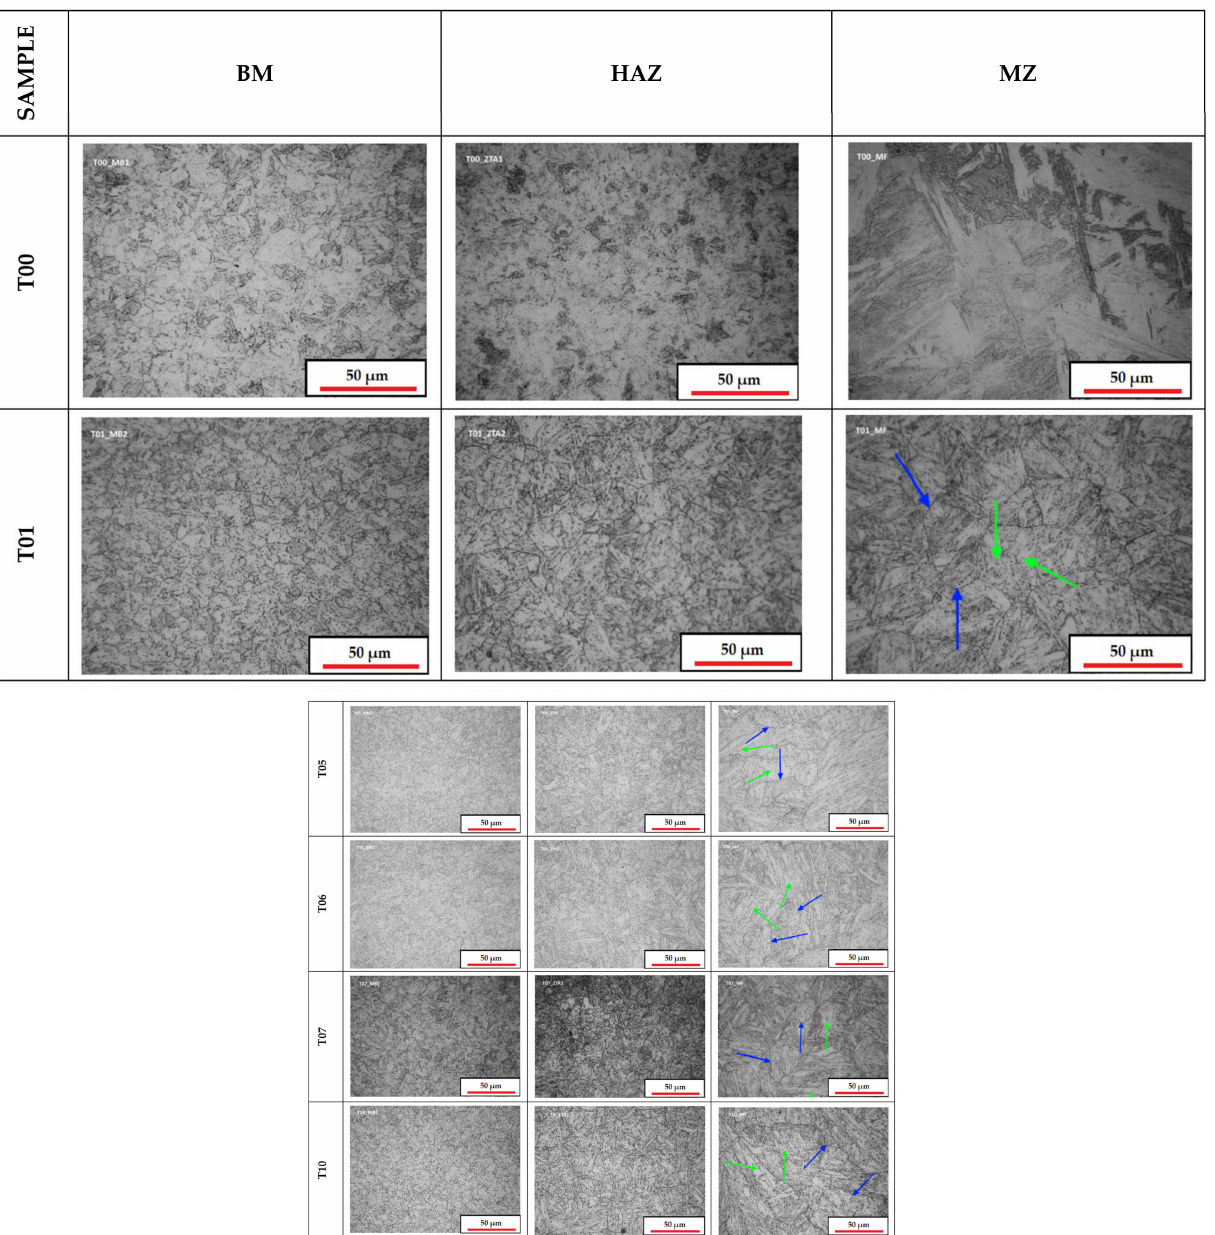
Figure 4. Micrographs for all the different zones for the samples with distinct heat-treatments. Green arrows highlight the presence of M 23 C 6 precipitates, and the blue arrows indicate the grain